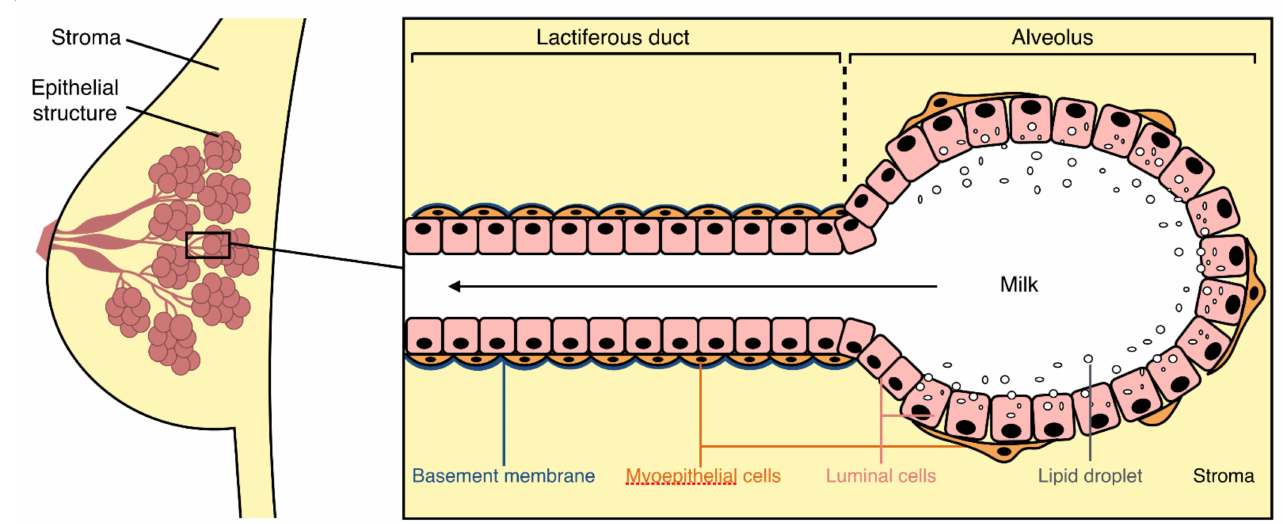
Figure 2. General organization of the mammary gland and its epithelium. The mammary epithelium (pink) is a ramified structure embedded in a fibro-adipose connective tissue: the mammary stroma (yellow). The epithelial structure is ramified into different levels of lactiferous ducts leading to milk-producing alveoli. The bistratified mammary epithelium (black box) is composed of luminal cells (pink) in contact with the lumen (white) and myoepithelial cells (orange) in contact with both the basement membrane (blue) and the